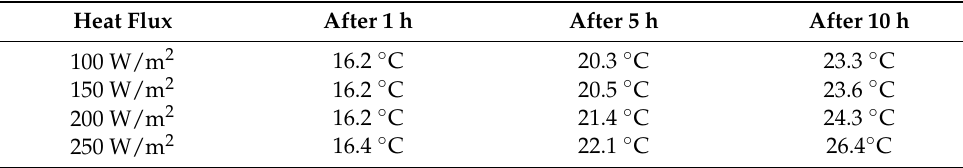
Table 4. The average temperature on the surface of the wall for